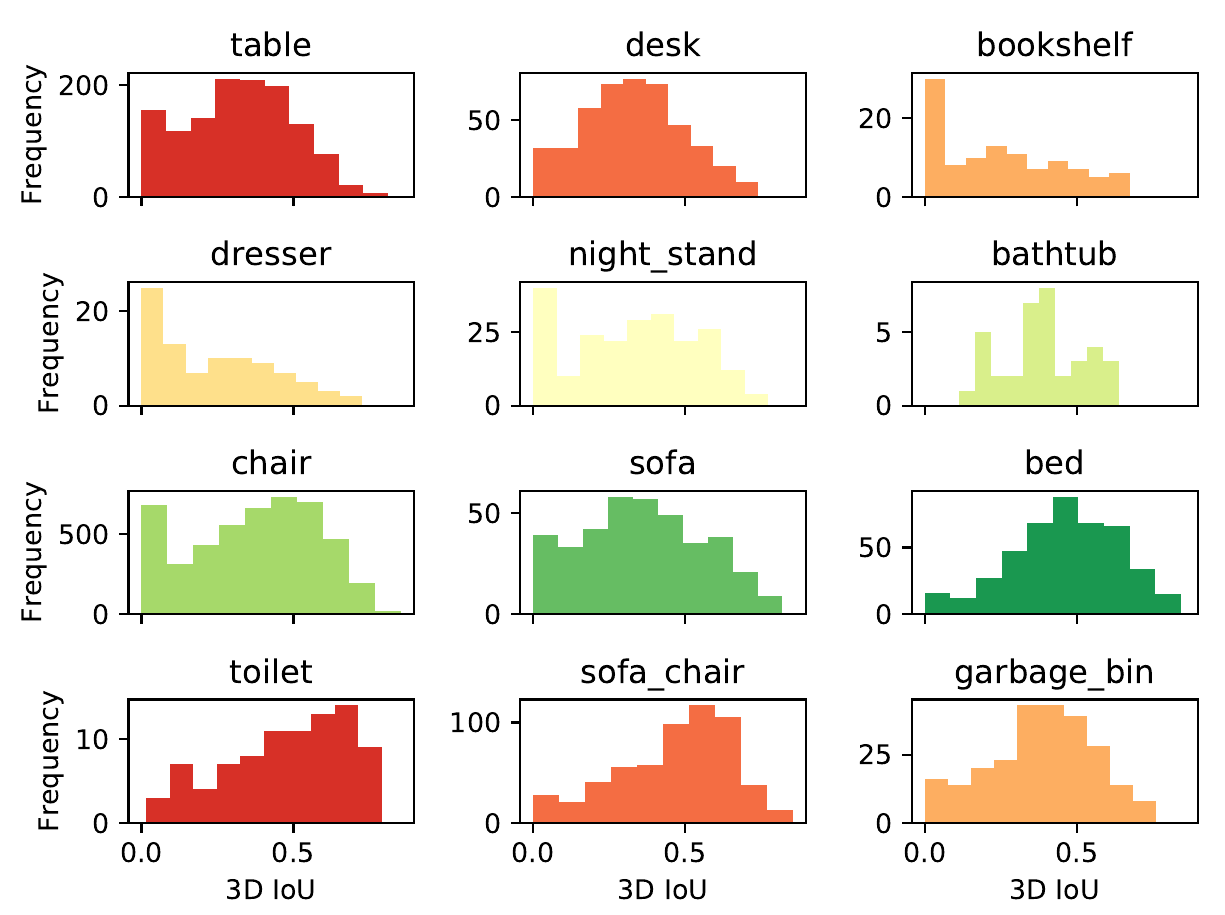
Figure 11. Histogram of 3D IoU. Histograms are not normalized.